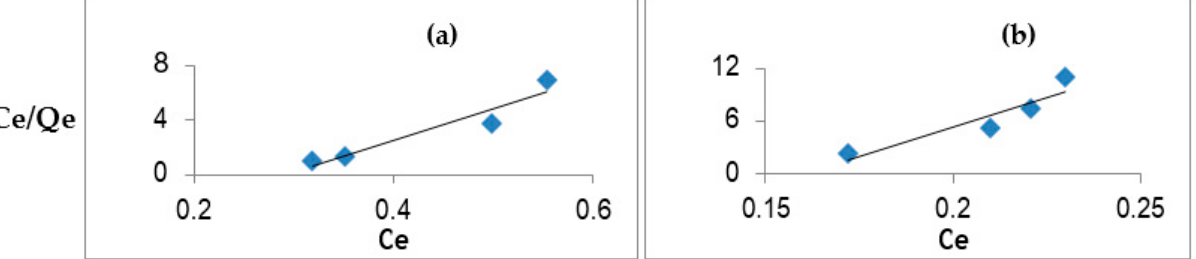
Figure 2. Langmuir adsorption isotherm for ( a ) daidzein and ( b ) genistein. Mean values obtained from three replicates are shown. Among the isoflavones, i.e., D, F, GE and BCA, and the Q max value of the biopolymer, the saturation concentration, i.e., 1 mg/mL and 1.5 mg/mL, was found to be in the following order: daidzein > genistein > biochanin A > formononetin, respectively. As K L is related to the energy of the adsorption process, a trend was generated based on the adsorption energy of the phytoestrogens and can be inferred as daidzein > genistein > biochanin A > formononetin. Exposure of the biopolymer to RAW264.7 cell lines, at different doses (Table 3), indi- cated no significant ( p > 0.05) decline in cell viability over 24 and 48 h exposure for the Table 2. Isothermal parameters of the phytoestrogens treated with the purified E. hirae biopolymer.